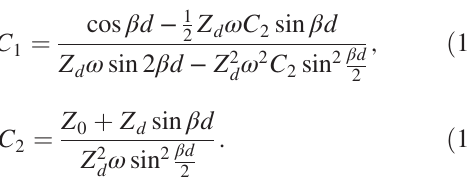
birefringent board is 8 × 10 mm 2 ( 0 . 27 λ × 0 . 33 λ ), which